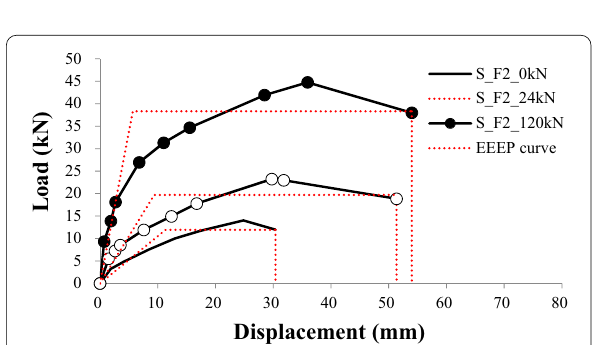
Fig. 11 Load–displacement curves depending on the vertical load